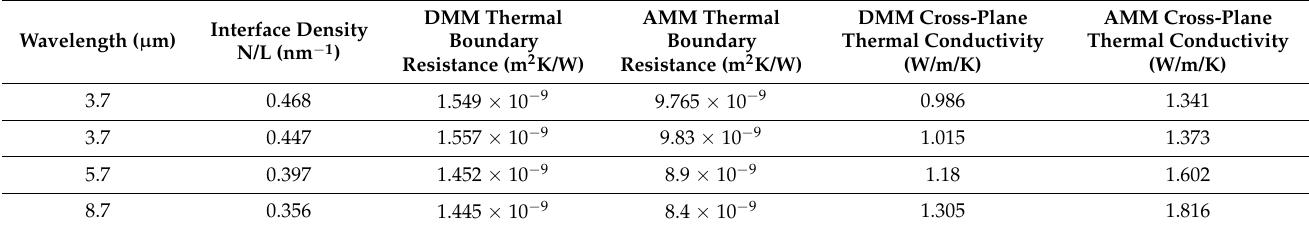
Table 3. Results of calculation of cross-plane conductivity and TBR using the DMM and